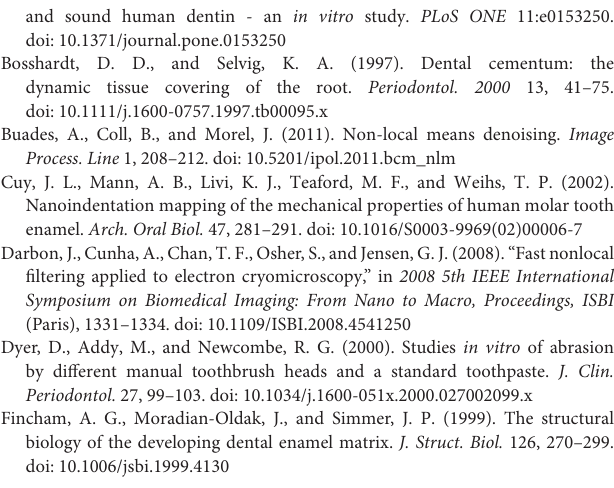
Supplementary Figure 1 | Light microscopy image of the cross section of a porcine tooth used in this study. The image shows the presence of the enamel, dentin, cementum and cementoenamel junction. Scale bar is